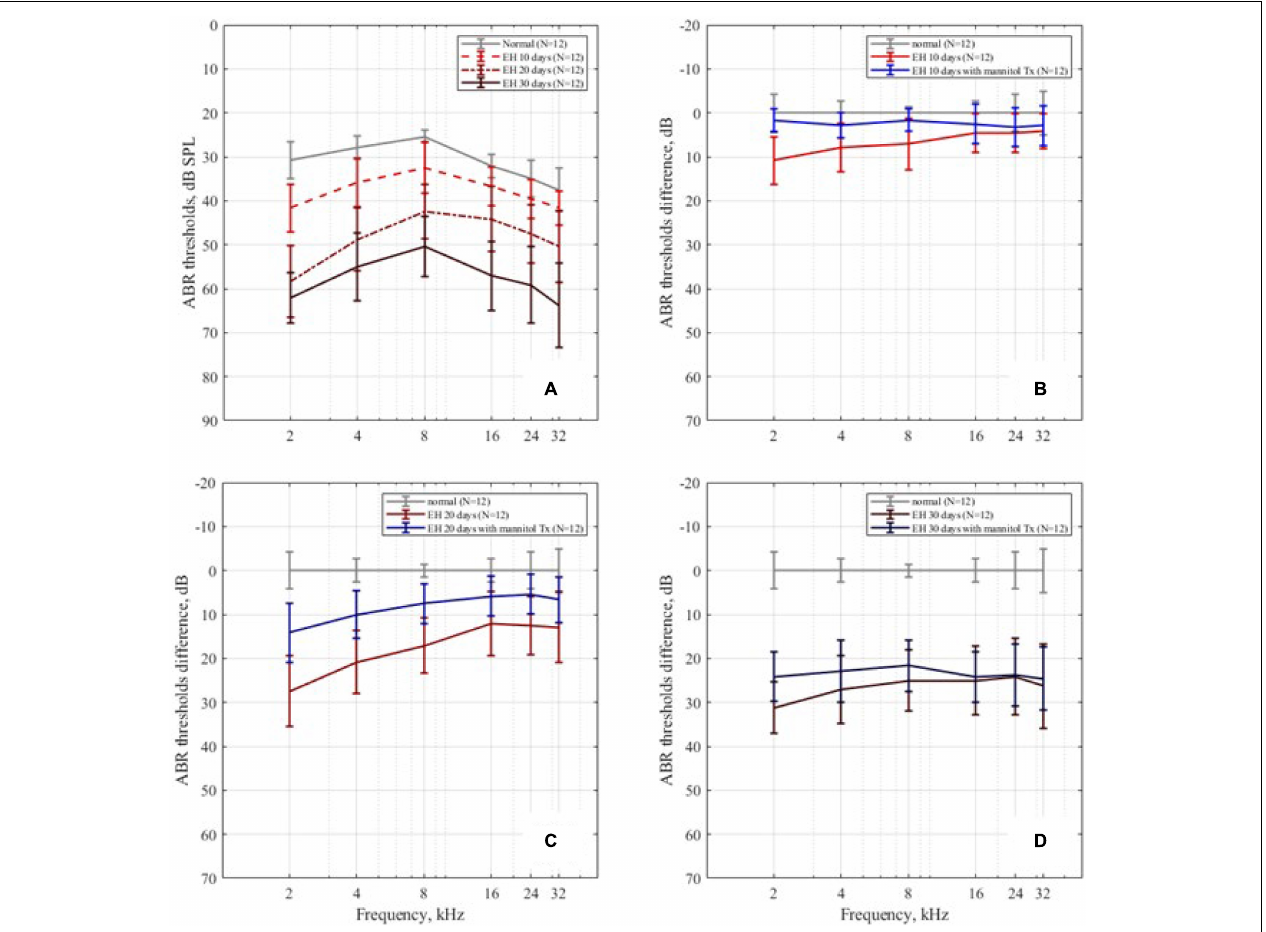
FIGURE 4 | The ABR thresholds change. (A) The ABR thresholds in the control, EH 10-, 20-, and 30-day groups, presenting with mean and SD; as the degree of EH became more severe, the thresholds increased. (B–D) The ABR threshold differences between the EH groups and the dehydration groups of 10, 20, and 30 days, compared with the control